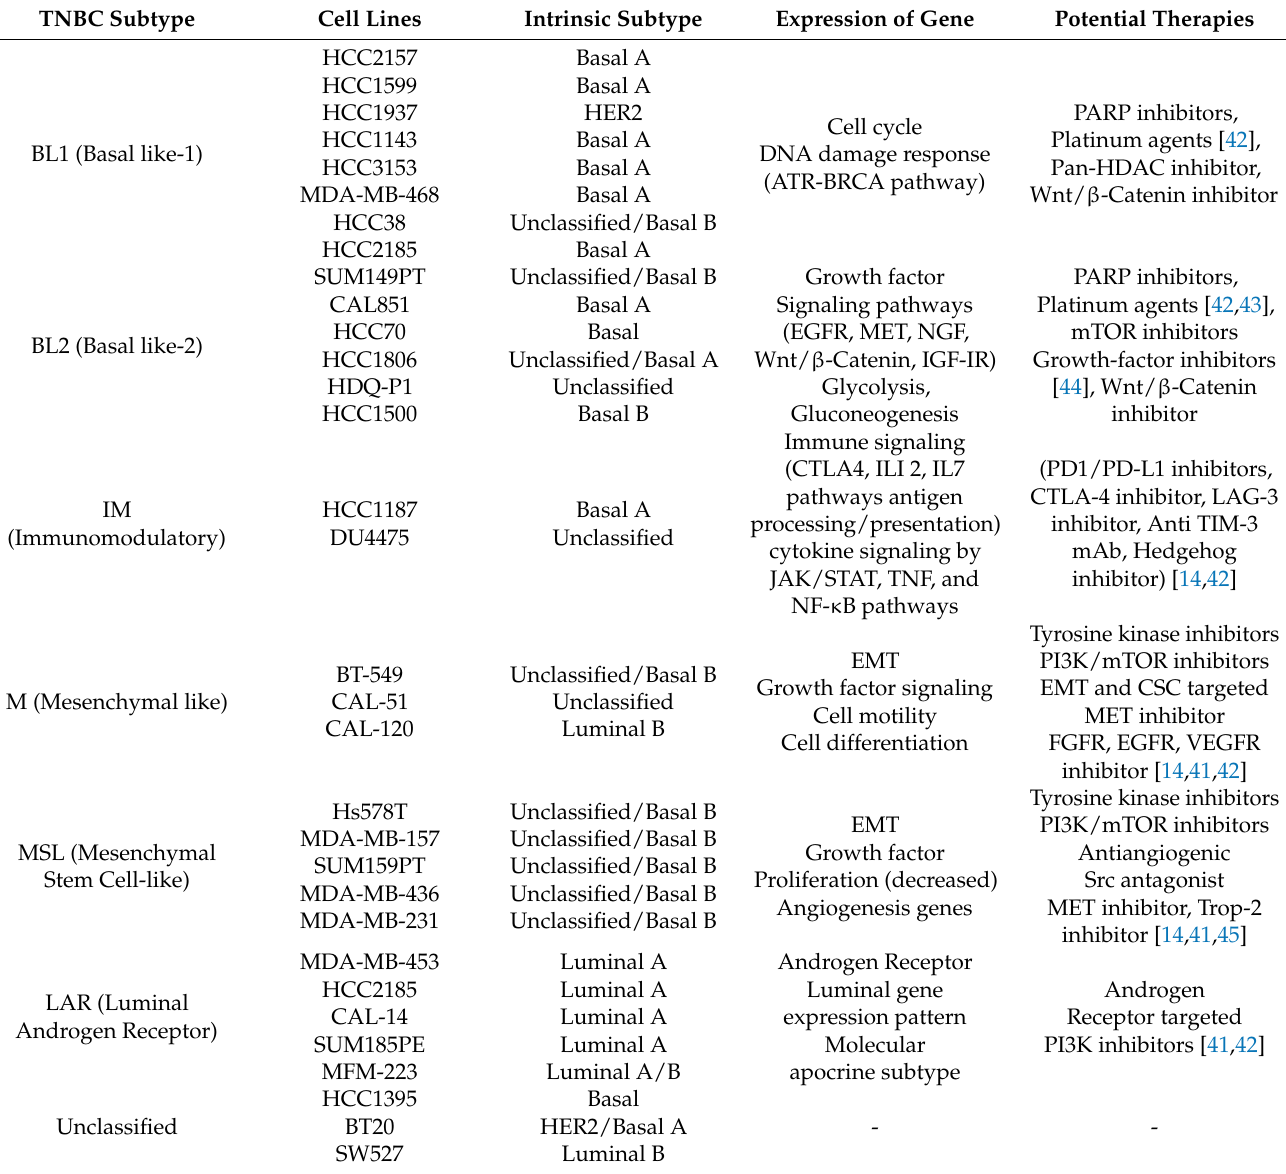
Table 1. Molecular classification of triple-negative breast cancer and ongoing clinical potential therapies in vitro adapted with permission from Lehmann et al. 2014 [41] and Ahn et al. 2016